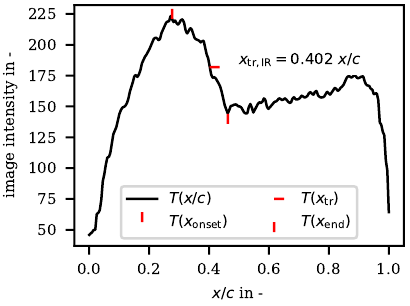
Figure 20. Thermal image intensity extracted along microphone-array line for time instance 11:22:27.